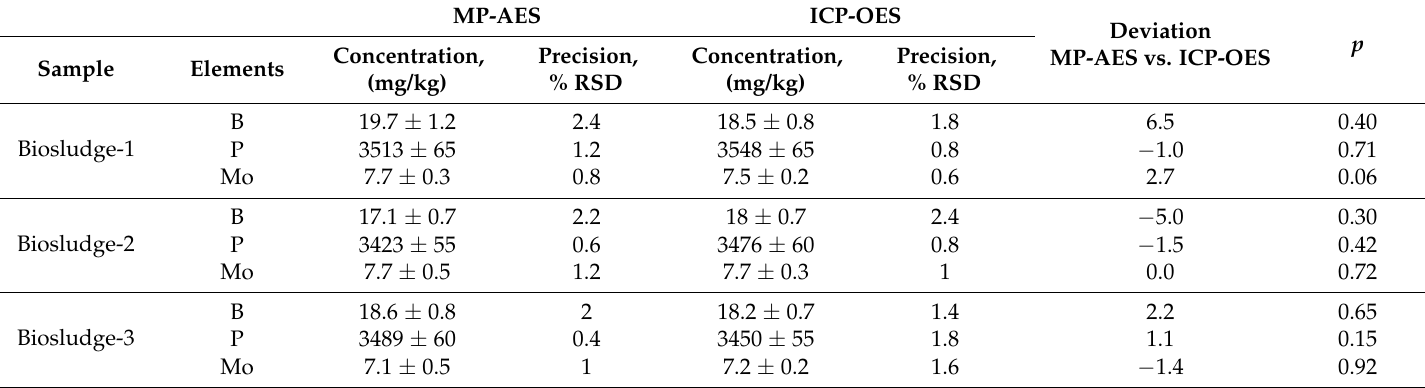
Table 6. Comparison of B, P, and Mo in analytical samples digested by USEPA Method 3051A and analyzed by using MP-AES &